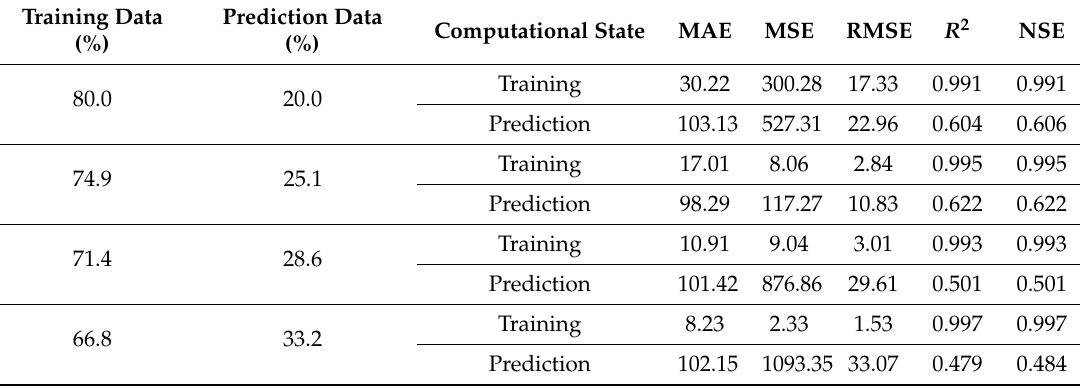
Table 7. Comparison of GRU performance with changes in length of training data and prediction